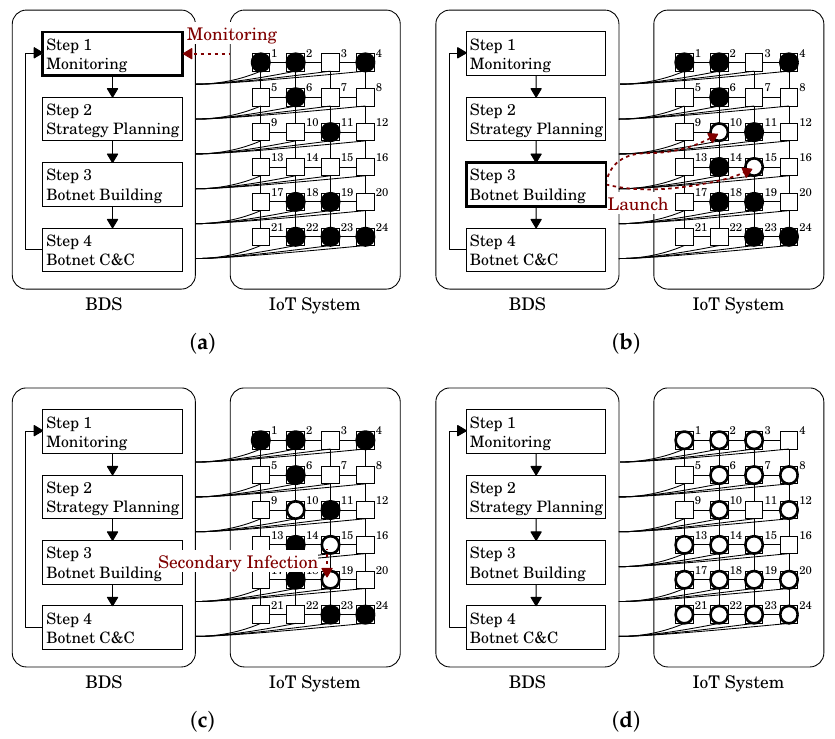
Figure 3. A state transition of the BDS, which illustrates how the BDS works. ( a ) State when the BDS detected a malicious botnet, which consists of 10 bots ( ). The BDS decided to adopt the few-elite (cid:32) strategy [23] for disinfecting the malicious botnet; ( b ) State in botnet building of Step 3. The BDS sent white-hat worms to the 10th and 15th nodes and built a white-hat botnet composed of two bots ( ); (cid:35) ( c ) State when the white-hat botnet spread by infecting the 19th device that had already been a malicious bot; ( d ) State in which the white-hat botnet wiped out the malicious botnet. However, many white-hat bots still stay